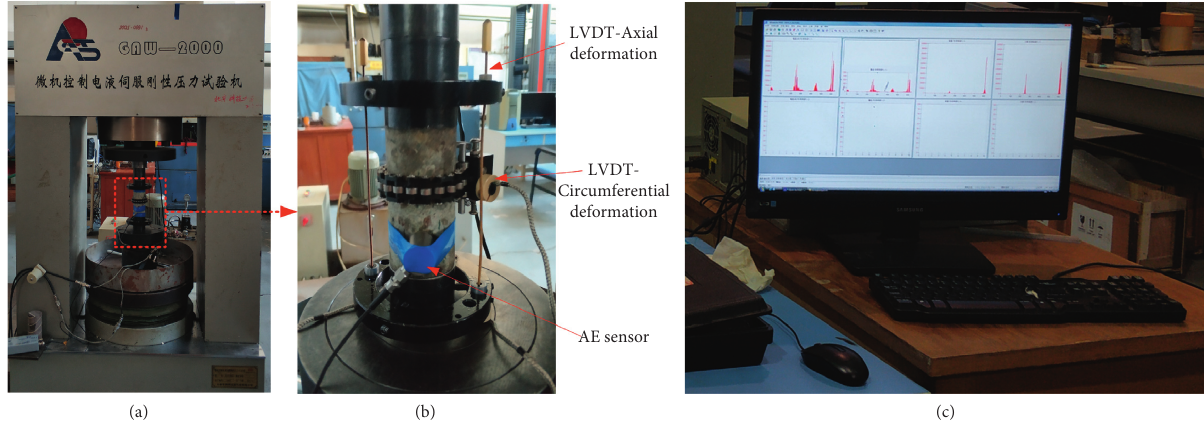
Figure 4: Test equipment: (a) GAW-2000 rock mechanical testing machine; (b) LVDT system and AE (AE) sensors; (c) AE21C AE monitoring system.